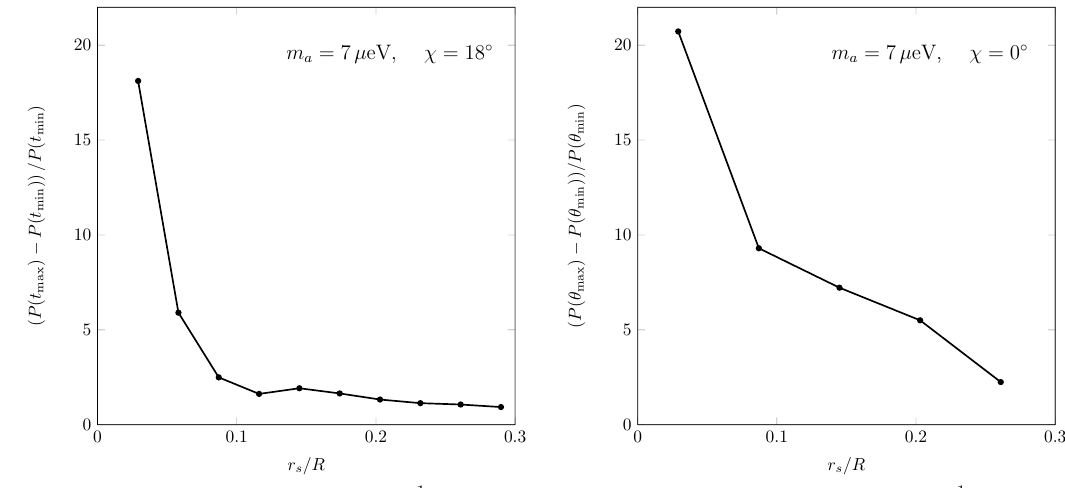
Figure 9 . Effect of Gravity on angular and time-variation. We display the effect of gravity on the time-dependence of the signal (left panel) for an oblique rotator with χ = 18 ◦ and the angu- lar dependence (right panel) for an aligned rotator χ = 0 . We again took a value m a = 7 µ eV. Here t and θ denote respectively the time and angle for which the power is maxi- max / min max / min mum/minimum.